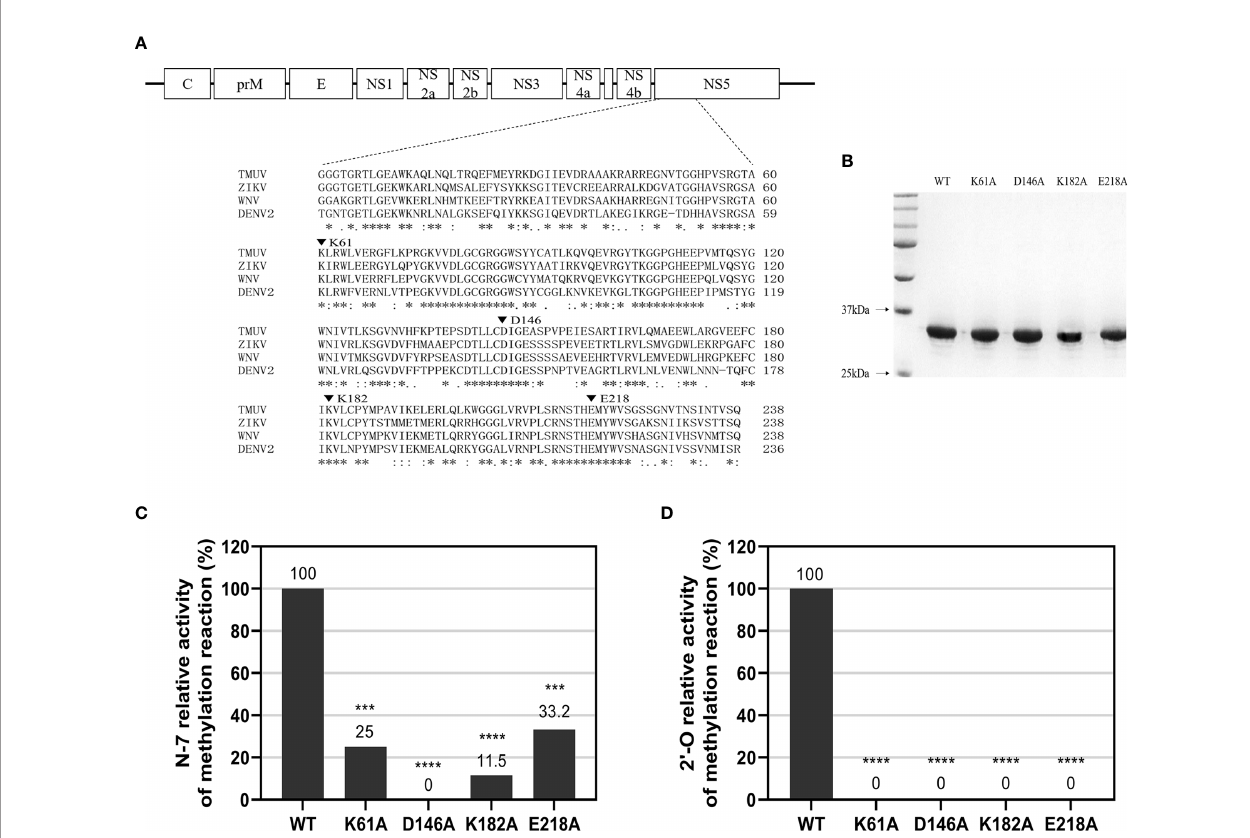
FIGURE 1 | N-7 and 2 ’ -O cap methylations of the viral RNA by WT and mutant TMUV MTase. (A) Sequence alignment between TMUV MTase and several other fl avivirus MTase proteins. The MTase sequences of TMUV, ZIKV, WNV, and DENV2 are derived from GenBank accession numbers AIU44176.1, YP_002790881.1, NP_776022.1, and 5ZQK_A, respectively. The conserved K61-D146-K182-E218 tetrad residues mutated in this study are indicated by inverted triangle symbol. (B) Analysis of recombinant TMUV MTase proteins on 12% SDS-PAGE gels. (C, D) Effects of K61-D146-K182-E218 mutations on N-7 and 2 ’ -O methylations. Recombinant MTase proteins were assayed for GpppAG-RNA ! m7GpppAG-RNA and m7GpppAG-RNA ! m7GpppAmG-RNA conversions to indicate N-7 (C) and 2 ’ -O (D) methylations, respectively. The indicated RNA substrates were treated with recombinant MTase in the presence of SAM, digested with nuclease P1 (Sigma), and analyzed by thin-layer chromatography (TLC) plates. The G*pppAG, m7G*pppAG, and m7G*pppAmG products were measured by scintillation counting. The methylation activity of the mutant MTase was compared with that of the WT MTase (set as 100%). Each of these was conducted with three parallel replicates. **** P < 0.0001; *** P < 0.001 (one-way